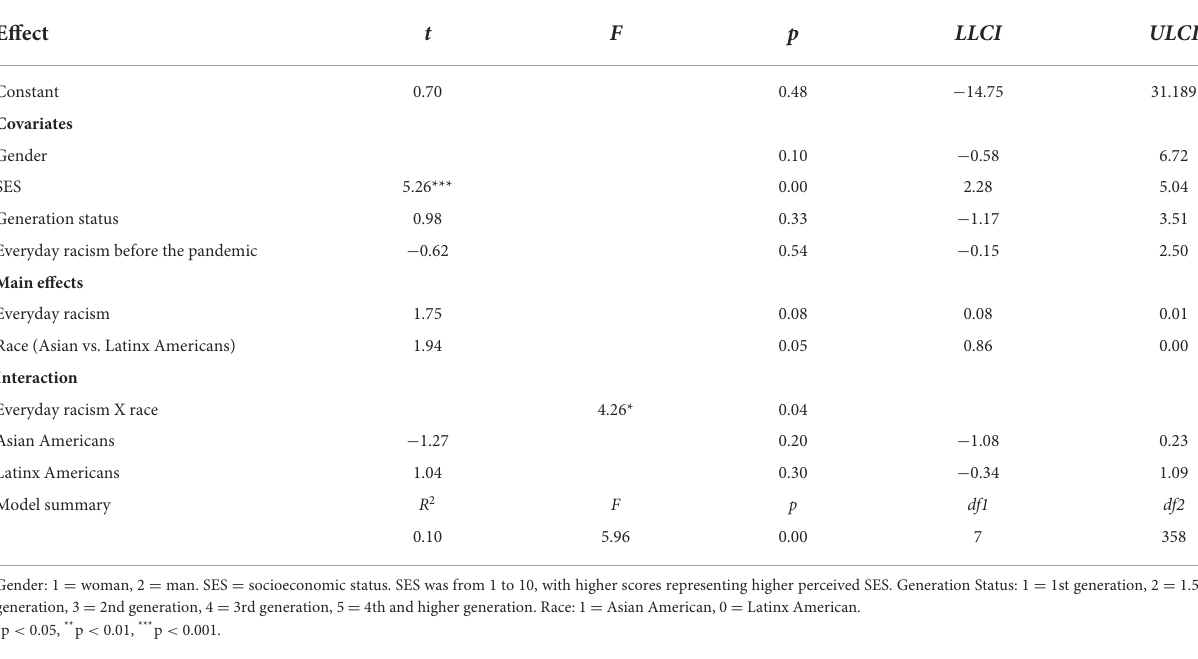
TABLE 3 Moderation results for everyday racism and race (Asian vs. Latinx Americans) with well-being as the outcome and everyday racism before the pandemic, gender, SES, and generation status as covariates for study 1.